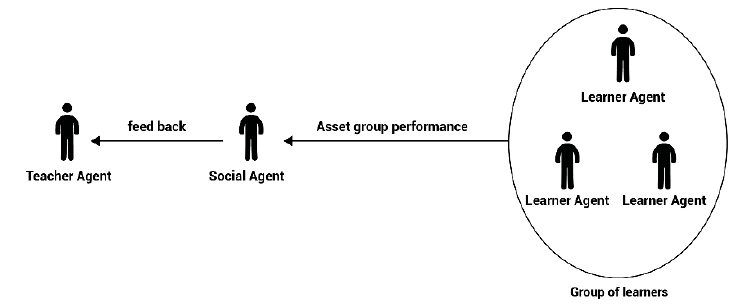
Figure 6. Assessment of group performance.